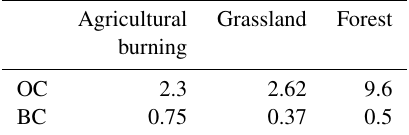
Table 1. Emission factors (gkg − 1 ) for the carbonaceous compo- nents of BB aerosol. The numbers are adopted from the GFED4 inventory (van der Werf et al., 2017) and are based on Akagi et al. (2011) and Andreae and Merlet (2001) with subsequent